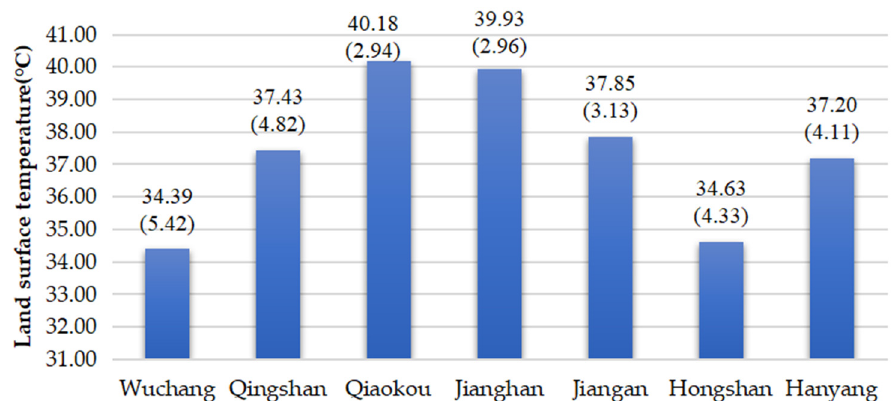
Figure 8. Land surface temperature of different districts.